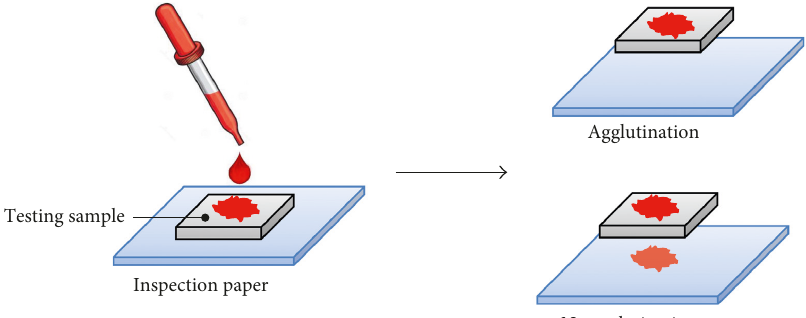
Figure 2: A schematic diagram of the blood agglutination